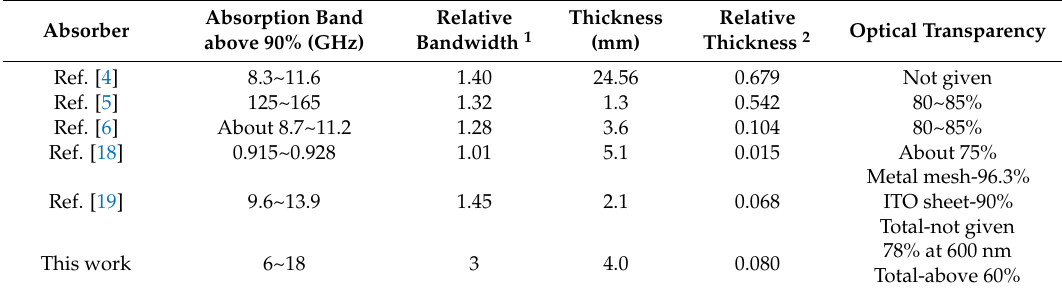
Table 4. Comparison on absorption performance between OTMMA in this work and previous